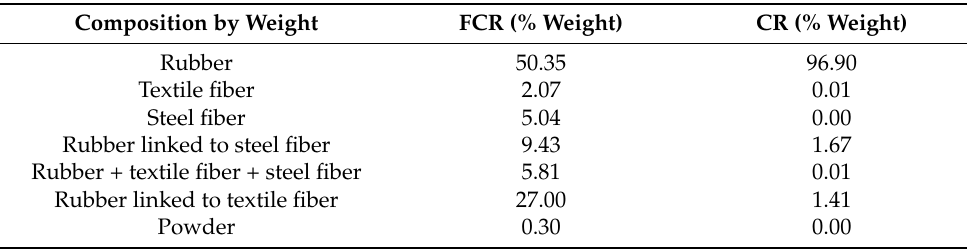
Table 4. Weight analysis of the main components of the two types of recycled rubber [34]. Copy-